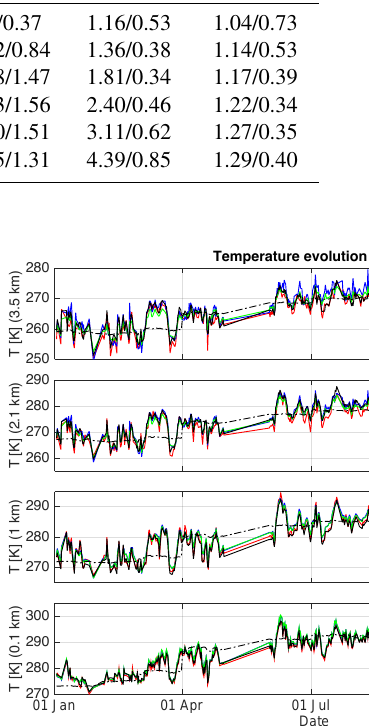
Table 3. Mean Tb and standard deviation between HATPRO and RSs for clear conditions. Elev. angle/freq.